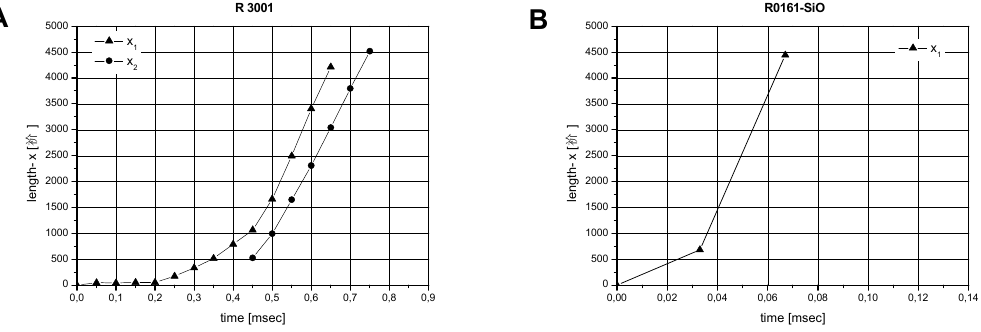
Figure 14. Drop dynamics as a function of time for materials of category II.